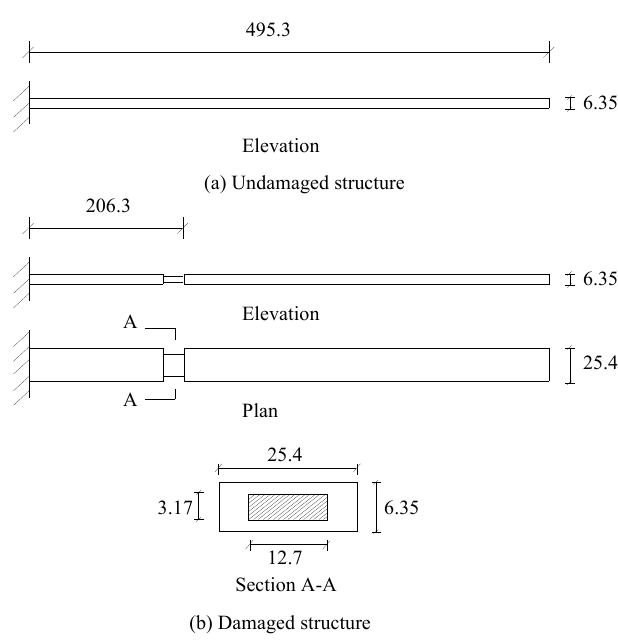
Figure 20. Configuration of the experimental beam [37]. ( a ) Undamaged structure; ( b ) Damage structure. Table 2. The first six natural frequencies of the undamaged and damaged beams [37].